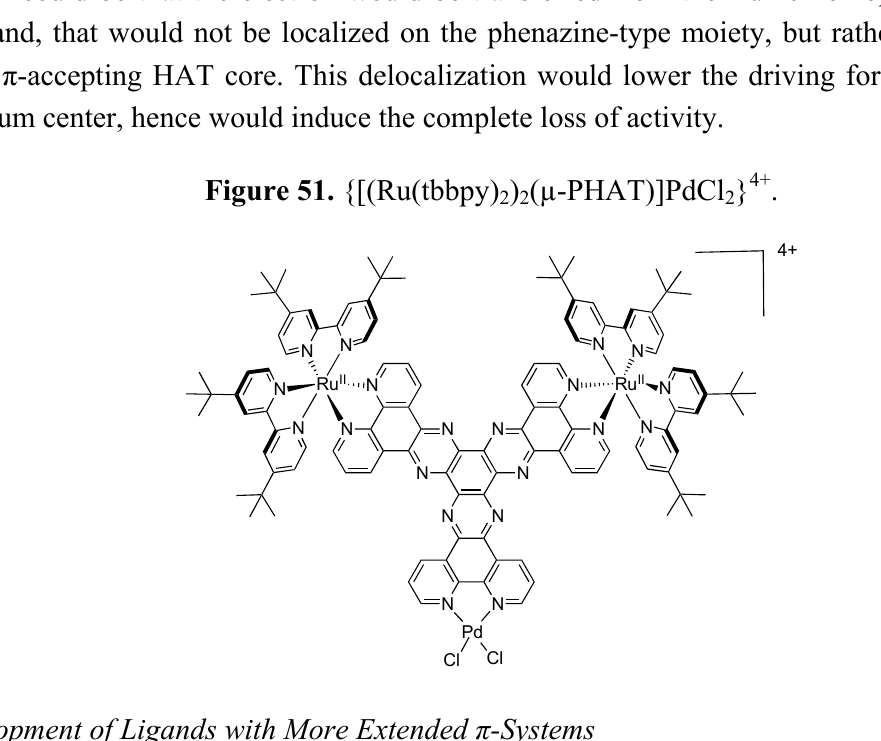
Figure 52. The trinuclear complex based on tatpp [Pd{(tatpp)Ru(phen)